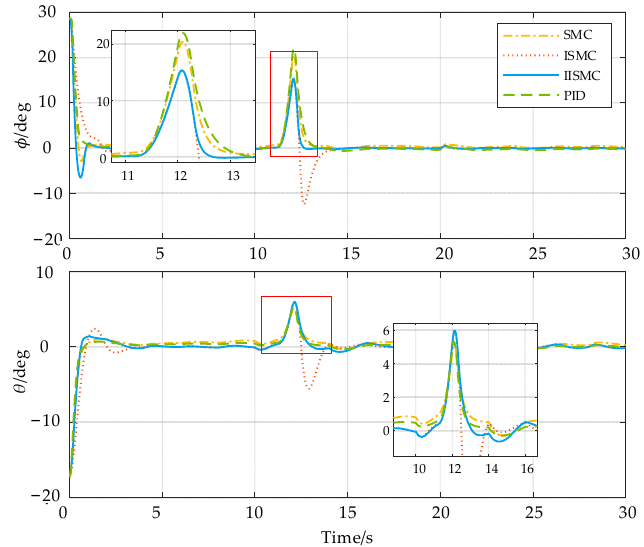
Figure 13. Attitude angles under four control methods in Scene 3.